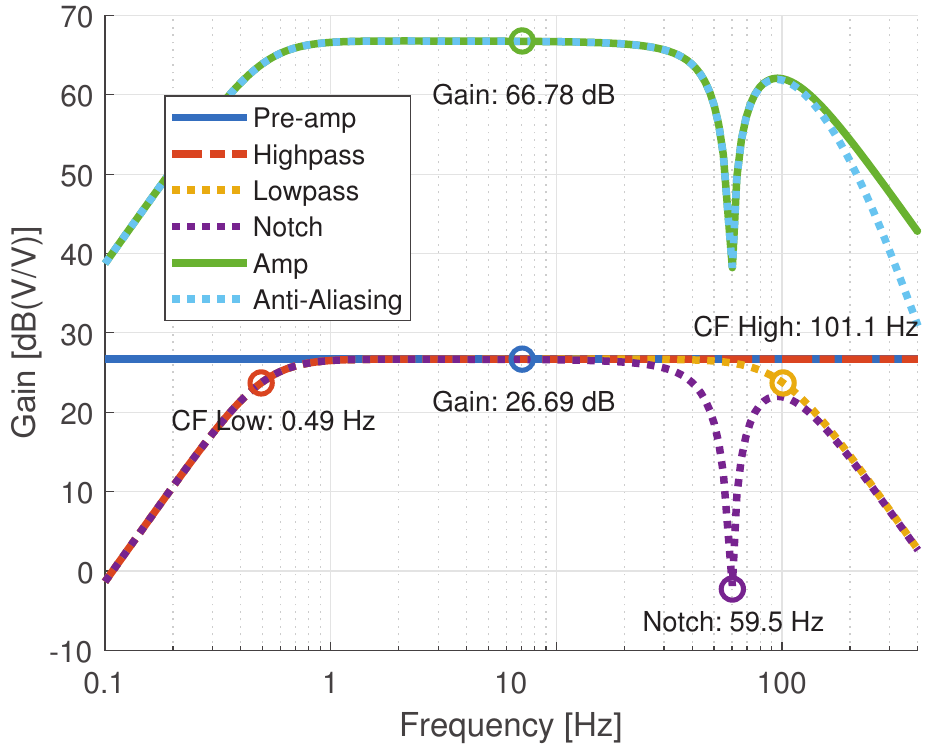
Figure 10. Magnitude response of all stages of circuit 2. “CF” stands for cut-off frequency and “Notch” refers to notch